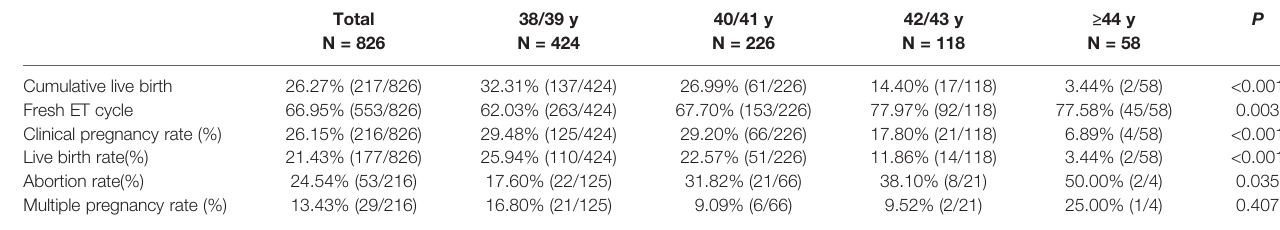
TABLE 2 | Cumulative live birth after a single ovarian stimulation cycle and pregnancy outcomes in fi rst ET cycles. Total